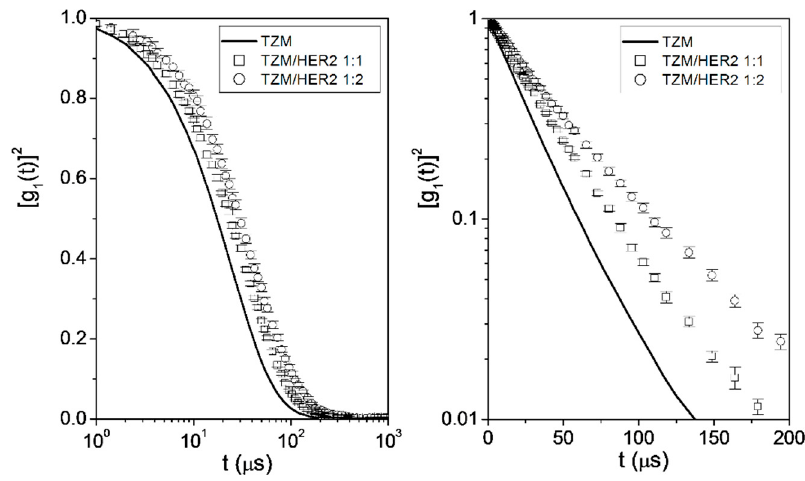
Figure 2. Squared electric field time autocorrelation function, [g 1 (t)] 2 , of TZM (solid line), complex 1:1 (cid:3) ), and complex 1:2 ( ) at T = 293 K. (  ), and complex 1:2 (  ) at T = 293 K. ( (cid:35)